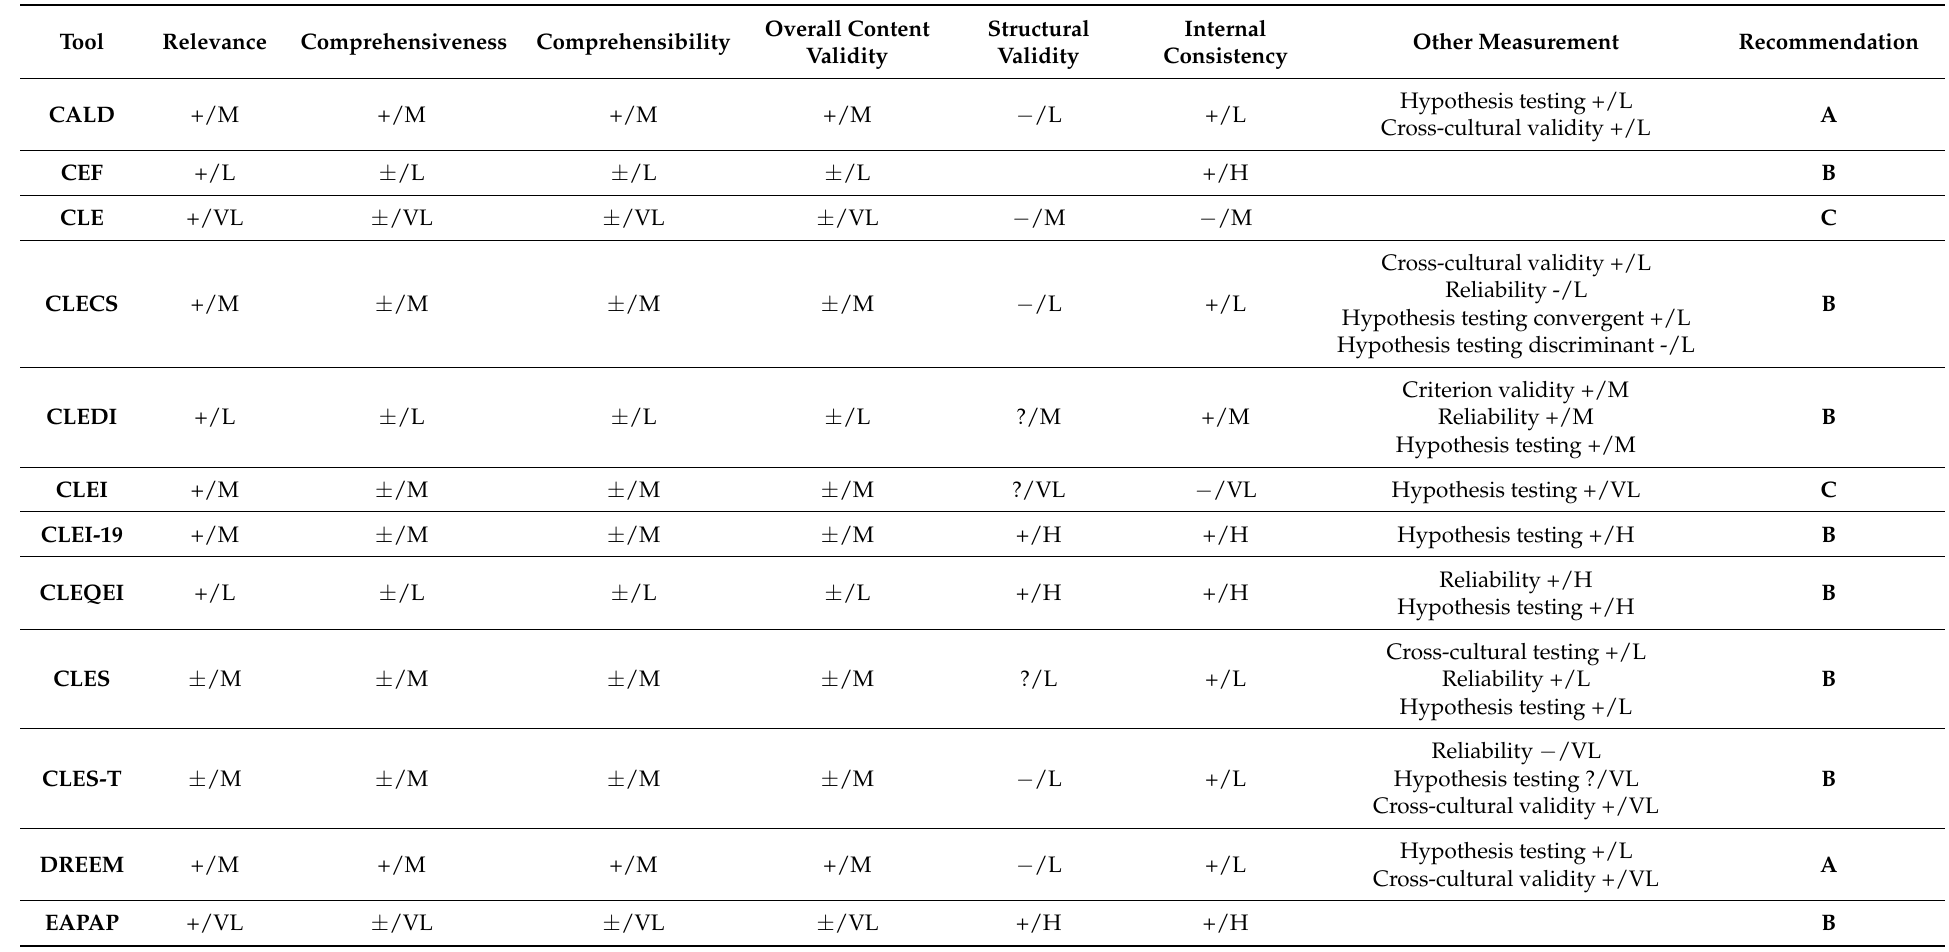
Table 2. Evaluation of content validity and psychometric properties and development of recommendations for the development of the